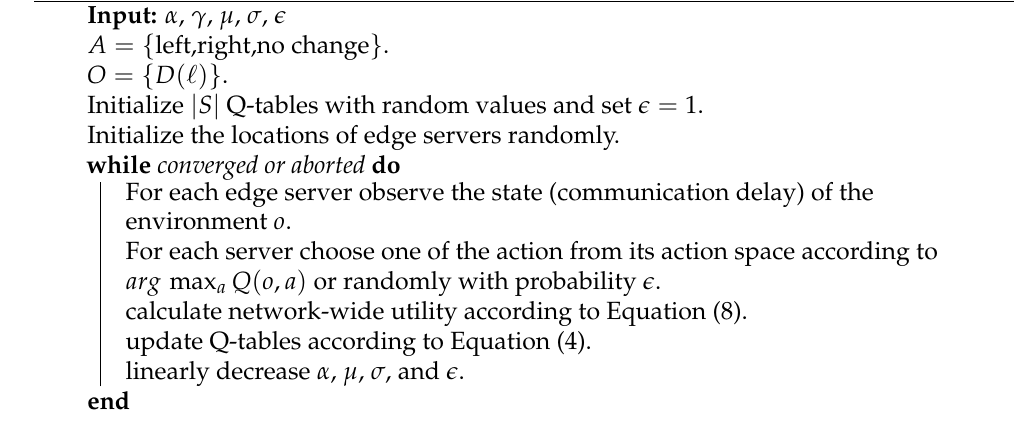
Algorithm 1: Multi-agent RL assisted mobile edge